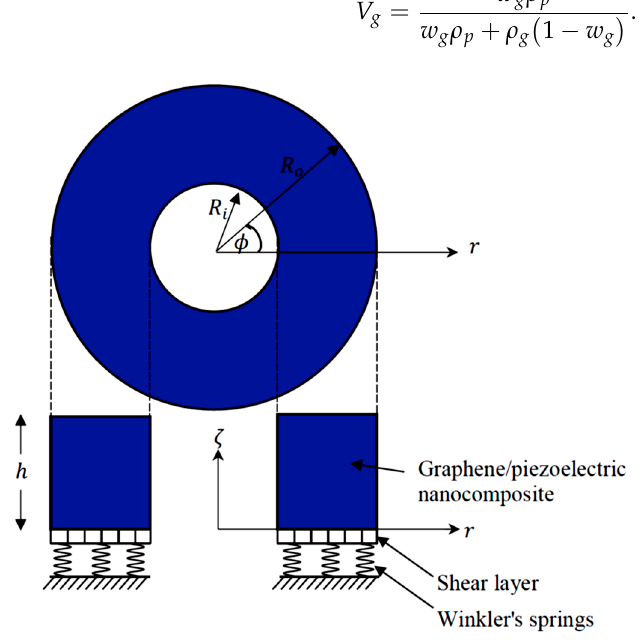
Figure 1. Configuration of a smart graphene/piezoelectric nanocomposite circular plate on an elastic substrate.